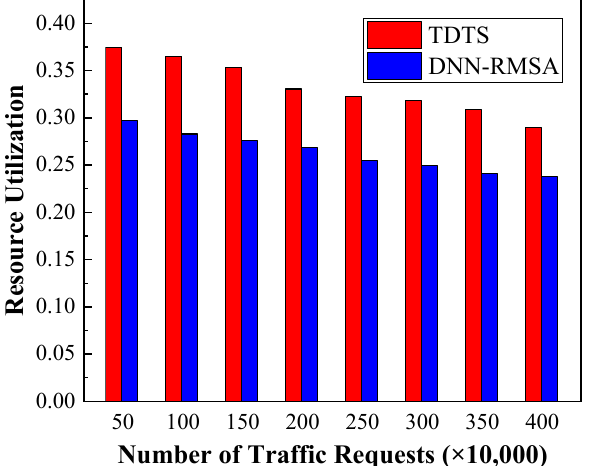
Figure 10. Resource utilization of TDTS, DNN-RMSA, and SPFF-RMSA.